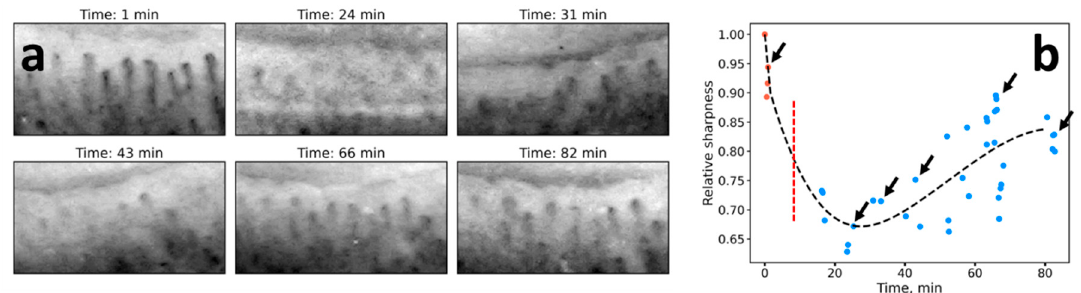
Figure 6. ( a ) The images of the human nailfold capillaries obtained with NVC before and after histamine application. Histamine was topically applied to the region of the nailfold. ( b ) The time course of the NVC image sharpness during histamine application. Each point represents the value of the estimated image sharpness. The dashed black line represents the fit of sharpness dependence on time using the least-square spline. The vertical dashed line represents the histamine application time; black arrows point to the values of capillaries images represented in panel ( a ).